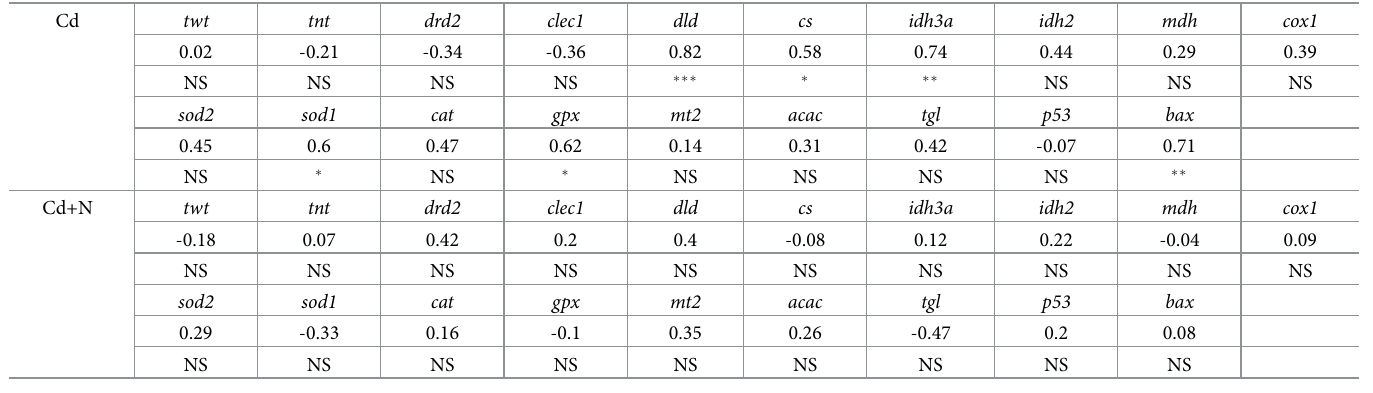
Table 2. Pearson correlation of [Cd]g and gene expression in Cd and Cd+N